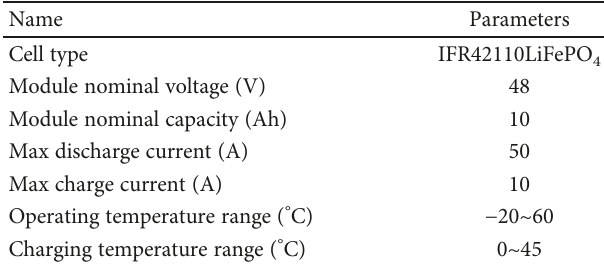
Table 1: Battery module speci fi cations.